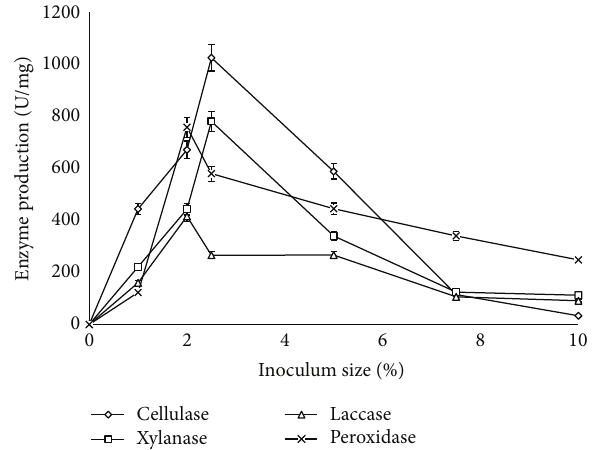
Figure 4: Effect of inoculum size on production of lignocellulolytic enzymes (error bars represent mean values and standard deviation of triplicate determination).